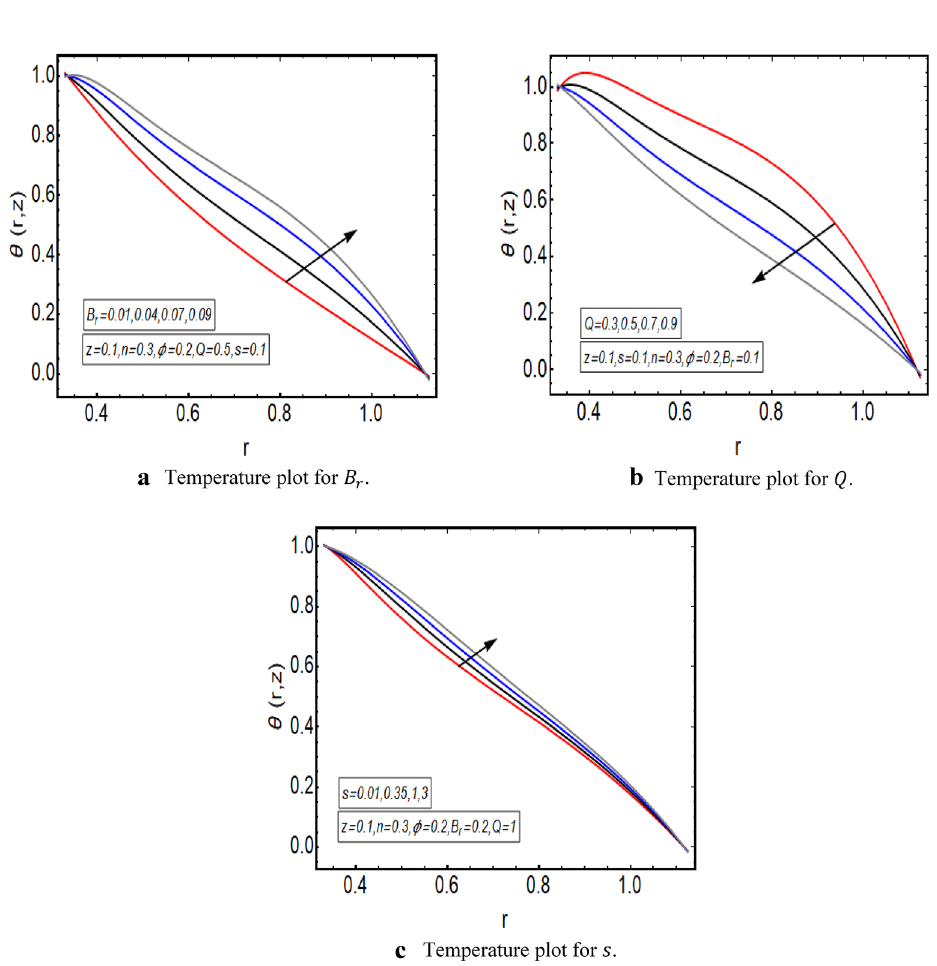
Figure 3. ( a ) Temperature plot for B r . ( b ) Temperature plot for Q . ( c ) Temperature plot for s